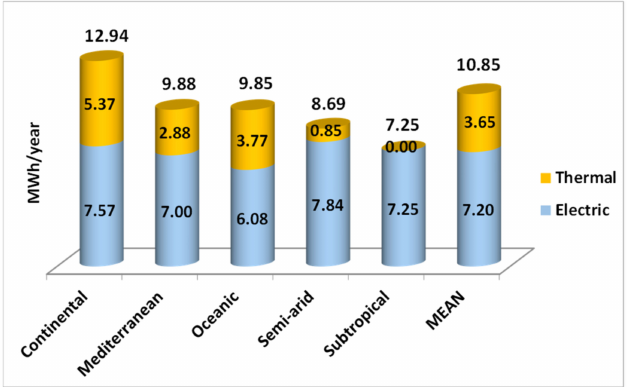
Figure 7. Thermal, electric, and total energy consumption per household of each Spanish climate zone.